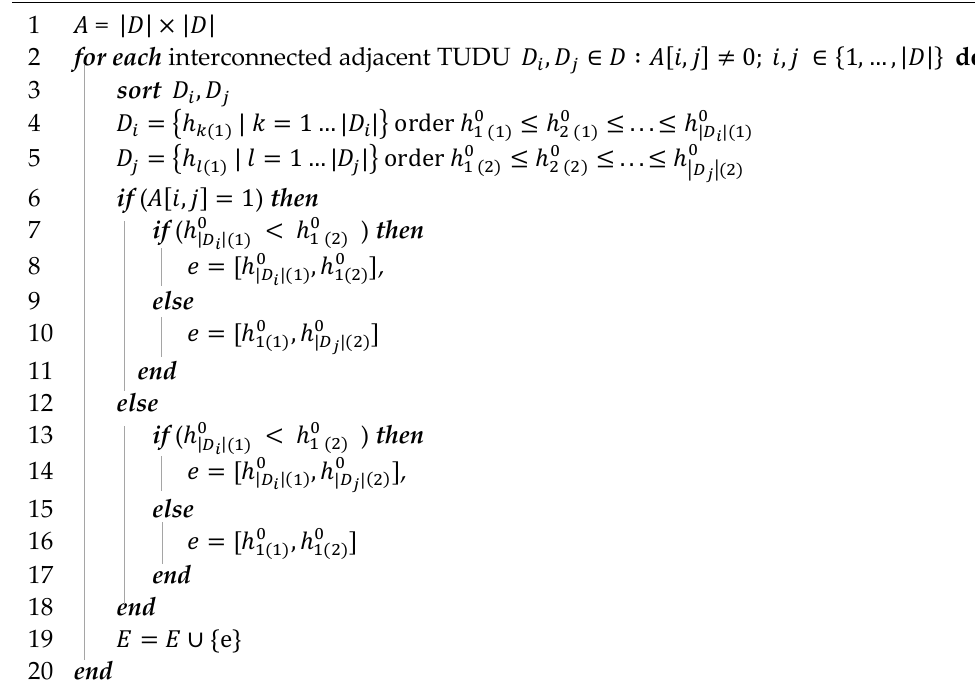
Figure 8. Construction of edges of individual TUDUs. Algorithm 3. Formation of edges between neighbouring TUDUs. Algorithm 3: Formation of edges between neighbouring TUDUs.